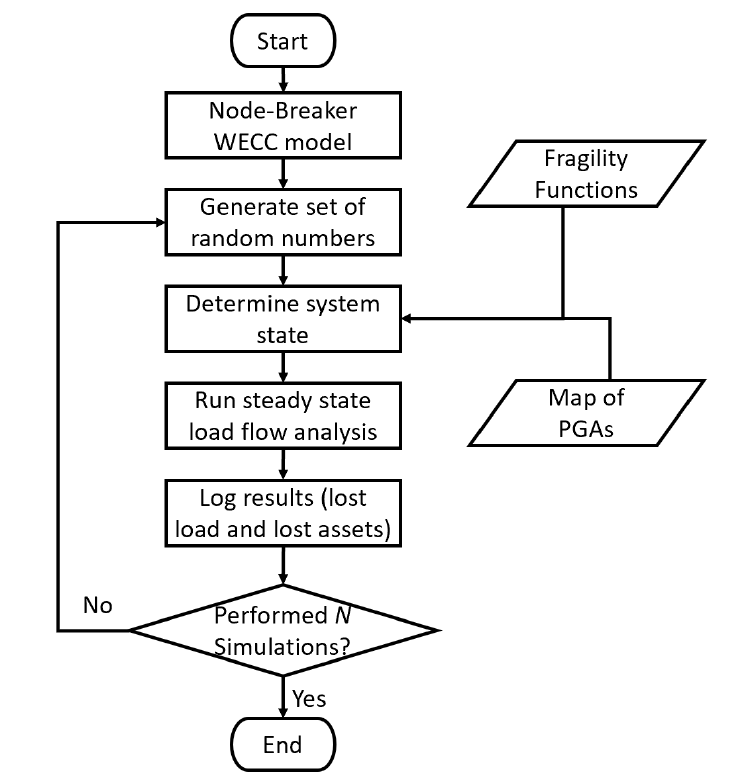
Figure 5. Flow chart for the Monte Carlo model